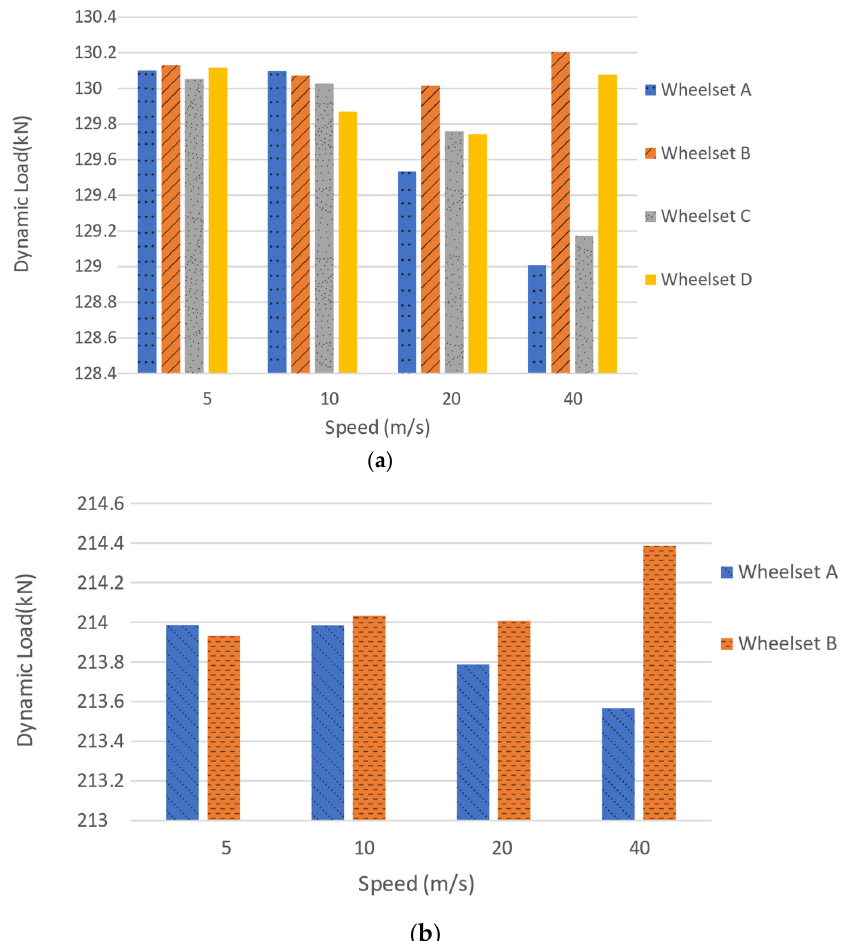
Figure 10. Wheelset dynamic load considering different speeds for ( a ) the Alfa Pendular and ( b ) freight wagon.